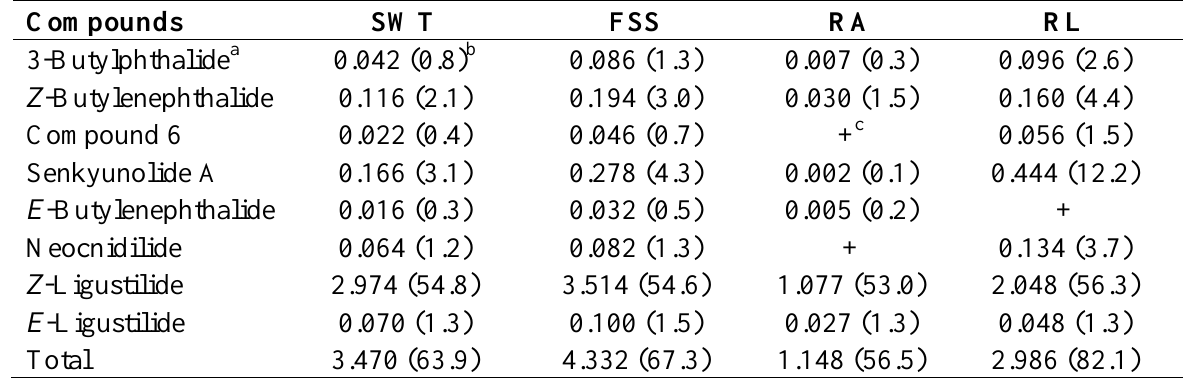
Table 2. Extractable content (mg) of eight phthalides based on mass spectra in SWT, FSS, RA and